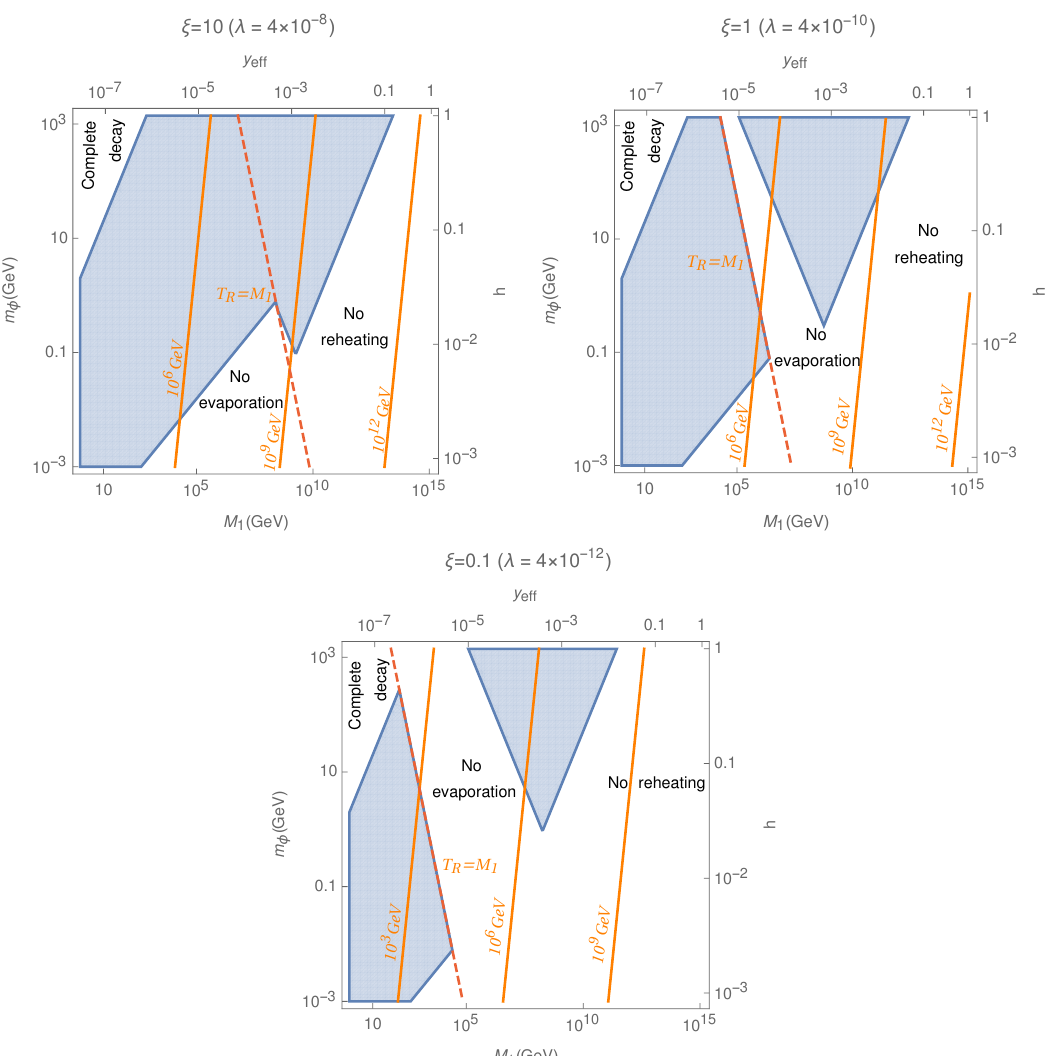
Figure 5 . Constraints on model parameters for (cid:24) = 0 : 1 ; 1, and 10, taking g ? = 100. The shaded blue regions correspond to parameter values satisfying all constraints in the WIMPlaton scenario. Orange lines represent di(cid:11)erent values for the reheating temperatures and the dashed line, M 1 = T R , limits the evaporation conditions. Condition (4.43) de(cid:12)nes the \complete decay" and \no reheating" regions and conditions (4.44), (4.45) limit the \no evaporation"